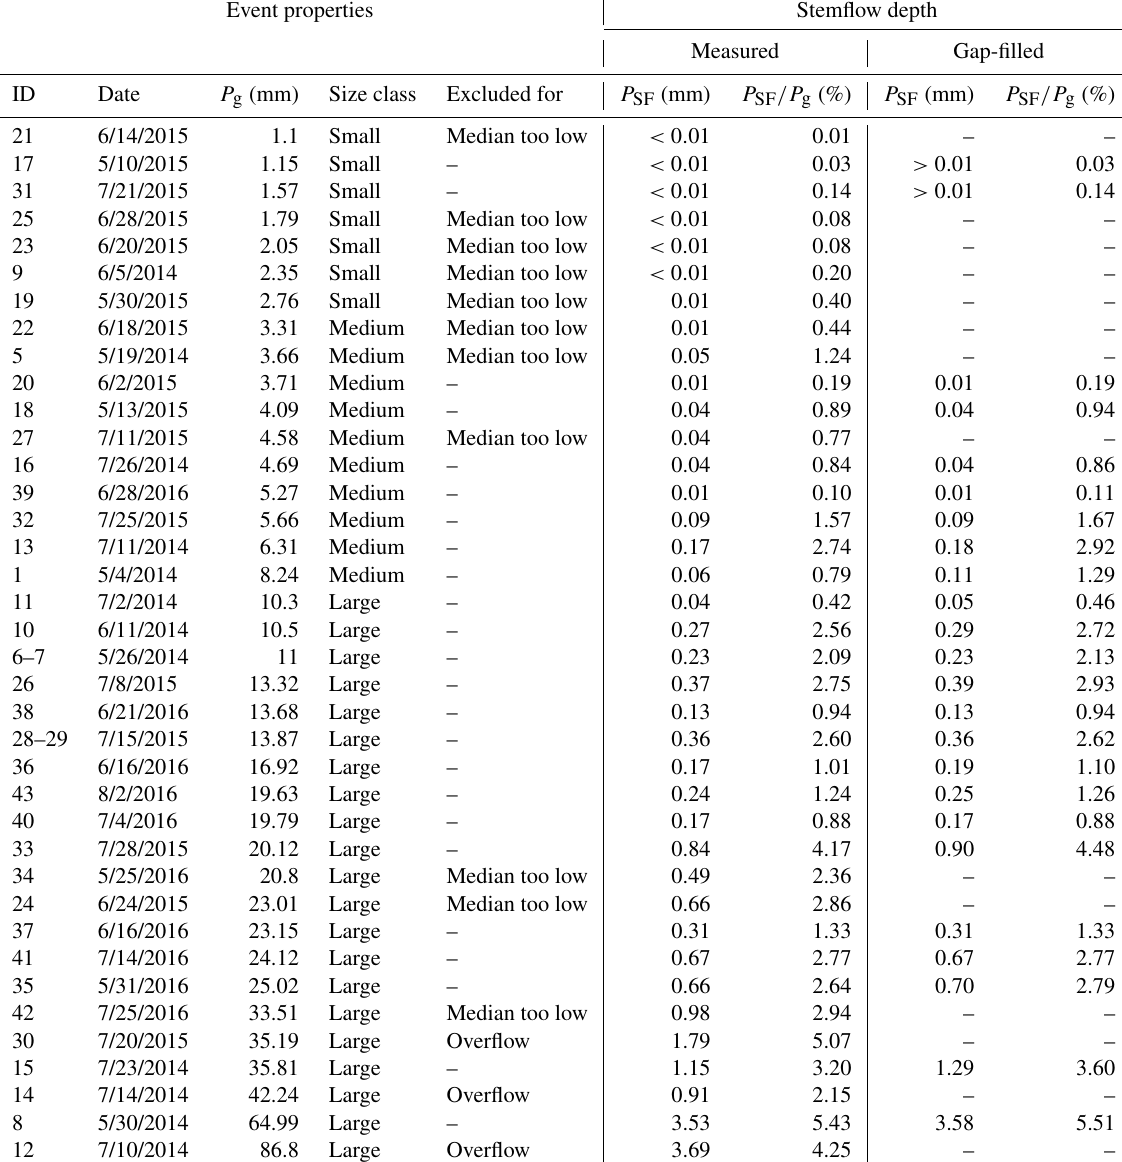
Table 3. Overview of collected stemflow precipitation events. Measured stemflow depth refers to cumulative stemflow of one event of all trees that could be evaluated. Events that were excluded from the linear mixed effects modelling are labelled and the reason for the exclusion is given (see Sect. 2 for more detail). Gap-filled stemflow is only available for events included in the modelling analysis. The overall gap rate was 6.2%, missing a mean of 5.2% of the calculated total stemflow. The date format is